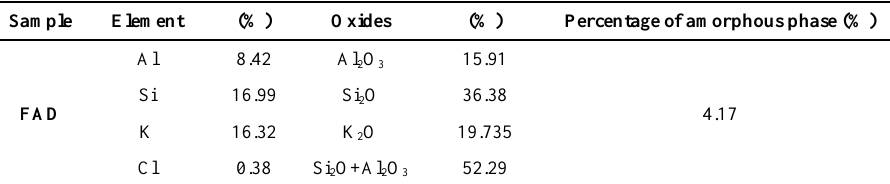
Table 4. Amorphous phase content of fly ash after denitrification.